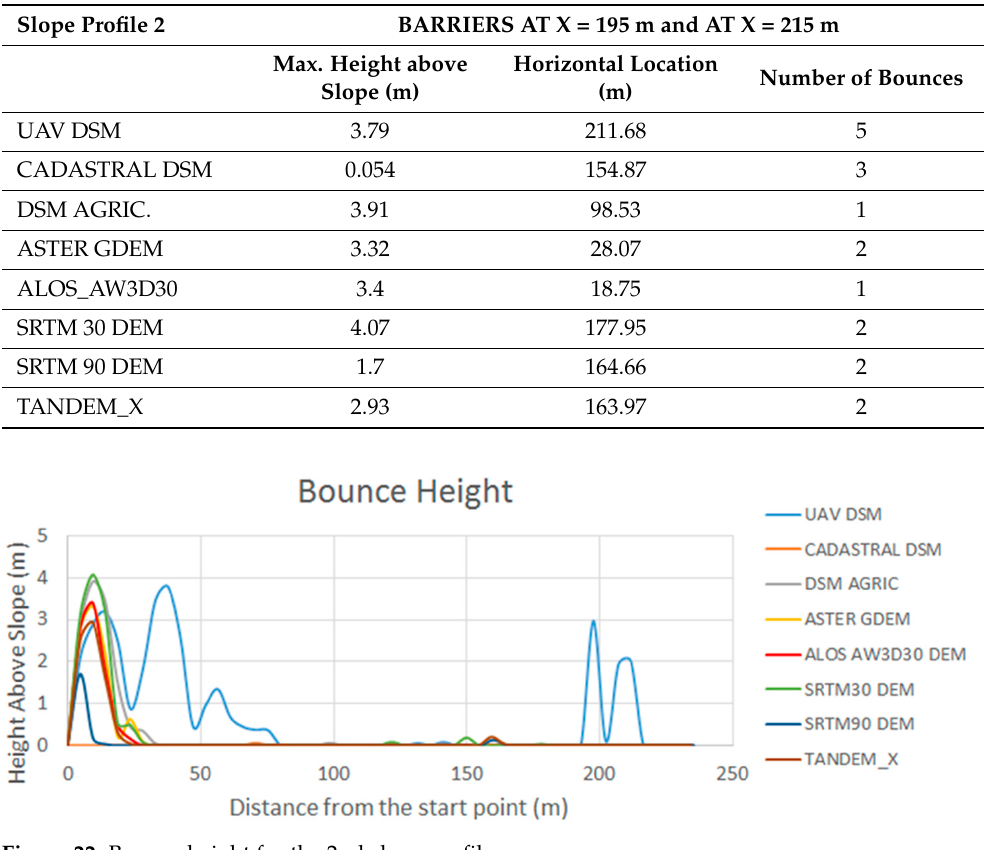
Table 13. Total kinetic energy distribution at x = 117.3 m for the 2nd slope profile. Slope Profile 2